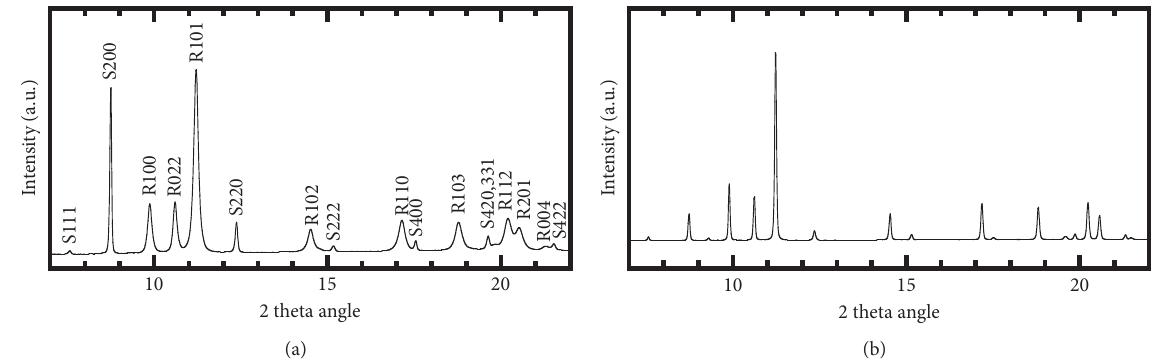
Figure 1: Comparison of powder X-ray diffraction data, before and after annealing. The upper and lower data show the results before and after annealing, respectively. Labels for the diffraction peaks are as follows: R–Re with hexagonal structure; S–B1-type NaCl. Numbers on the labels correspond to the indices of hexagonal or cubic symmetry. Monochromatic incident X-ray beam wavelength: λ � 0.4110 ˚A.